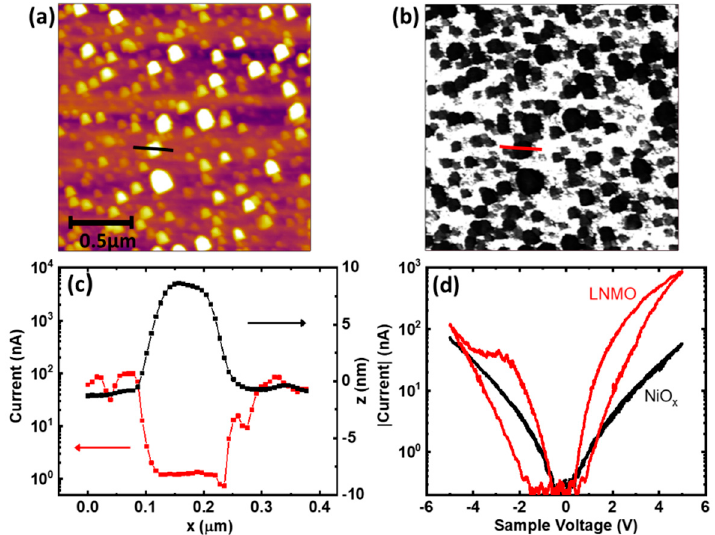
Figure 5. Local electric properties of the LNMO films with NiO x nanoparticles at the surface measured by C-AFM. ( a ) Topography image of a 2 × 2 µ m 2 area of the film. ( b ) Simultaneous current map of the same area taken (applying 1.5 V), where the less conductive parts can be related with the particles observed in the topography. ( c ) Current (red) and height (black) profiles of a NiO x nanoparticle and the surrounding LNMO film marked in ( a , b ). ( d ) I-V curves on the LNMO film (red) and on a particle (black), respectively.